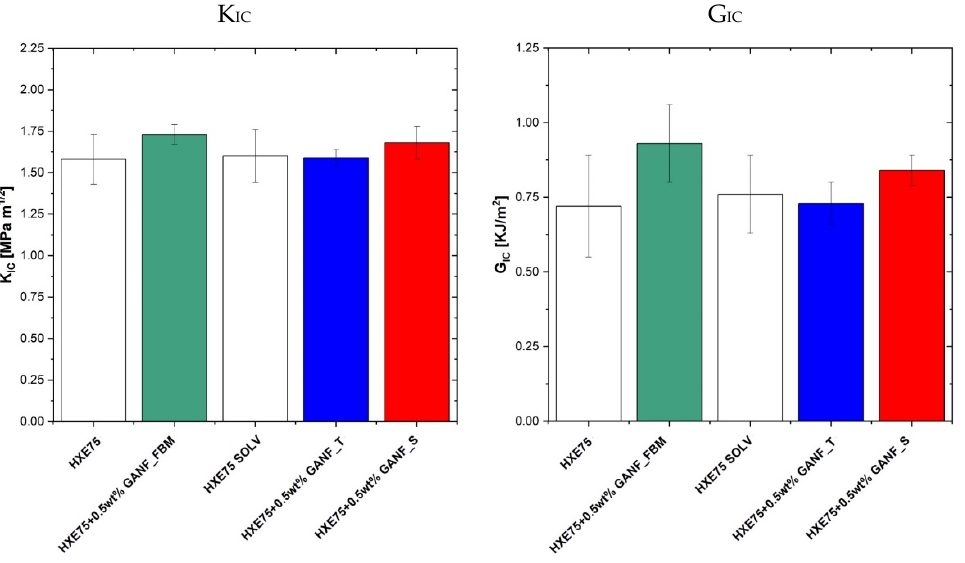
Figure 9. Fracture toughness results of the neat epoxy matrix and the GANF based nanocompo ‐ sites.